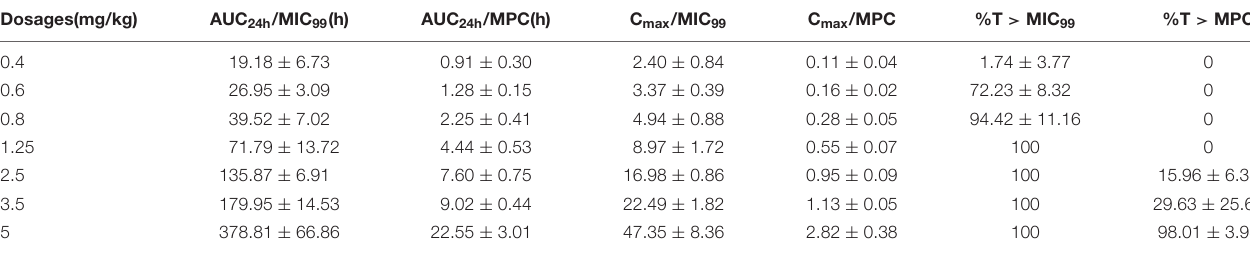
TABLE 2 | The PK/PD parameters of danofloxacin following multiple doses in a piglet tissue-cage infection model. Dosages(mg/kg)